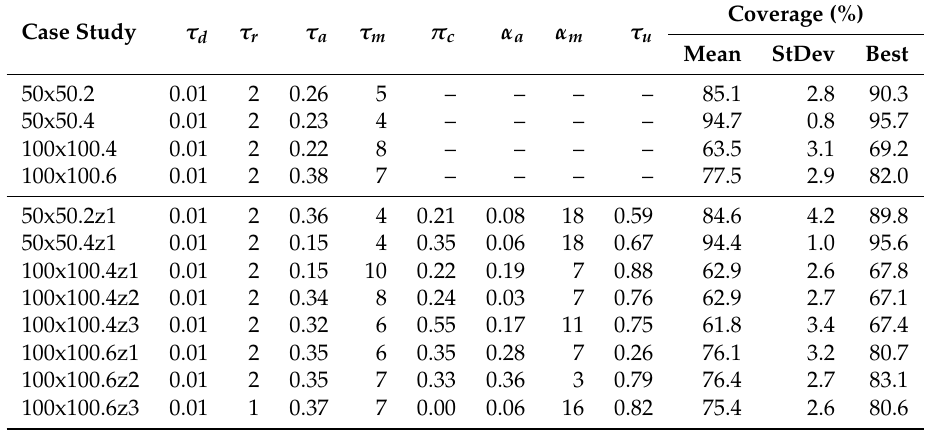
Table 6. Best configuration for each case study (parameters) followed by the mean, standard deviation and best coverage obtained when testing them in the 30 corresponding